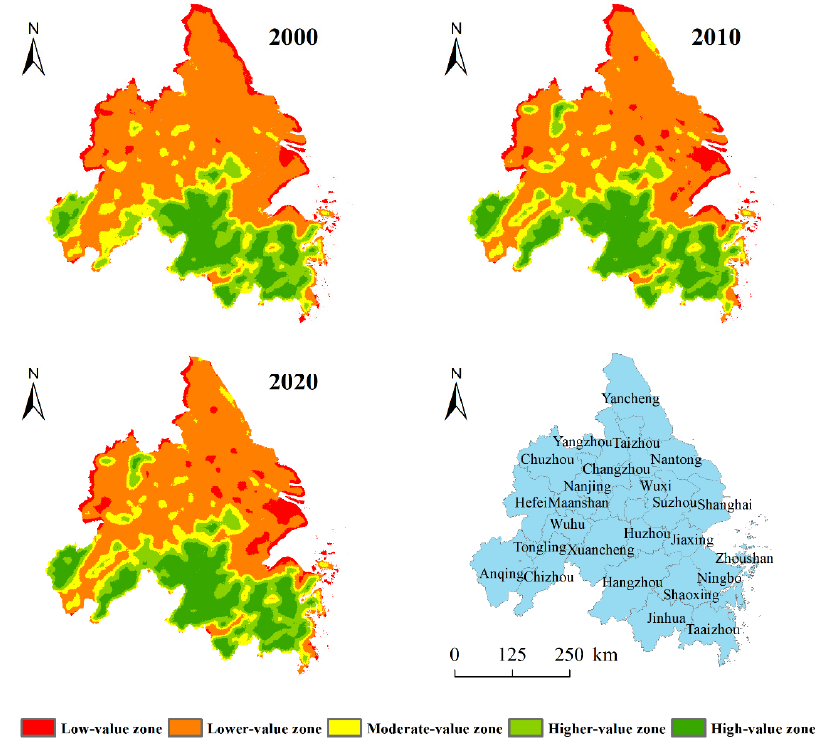
Figure 4. Distribution of EEQ in the YRDUA. Table 6. Transformation and contribution rate of major land use function types in the YRDUA during